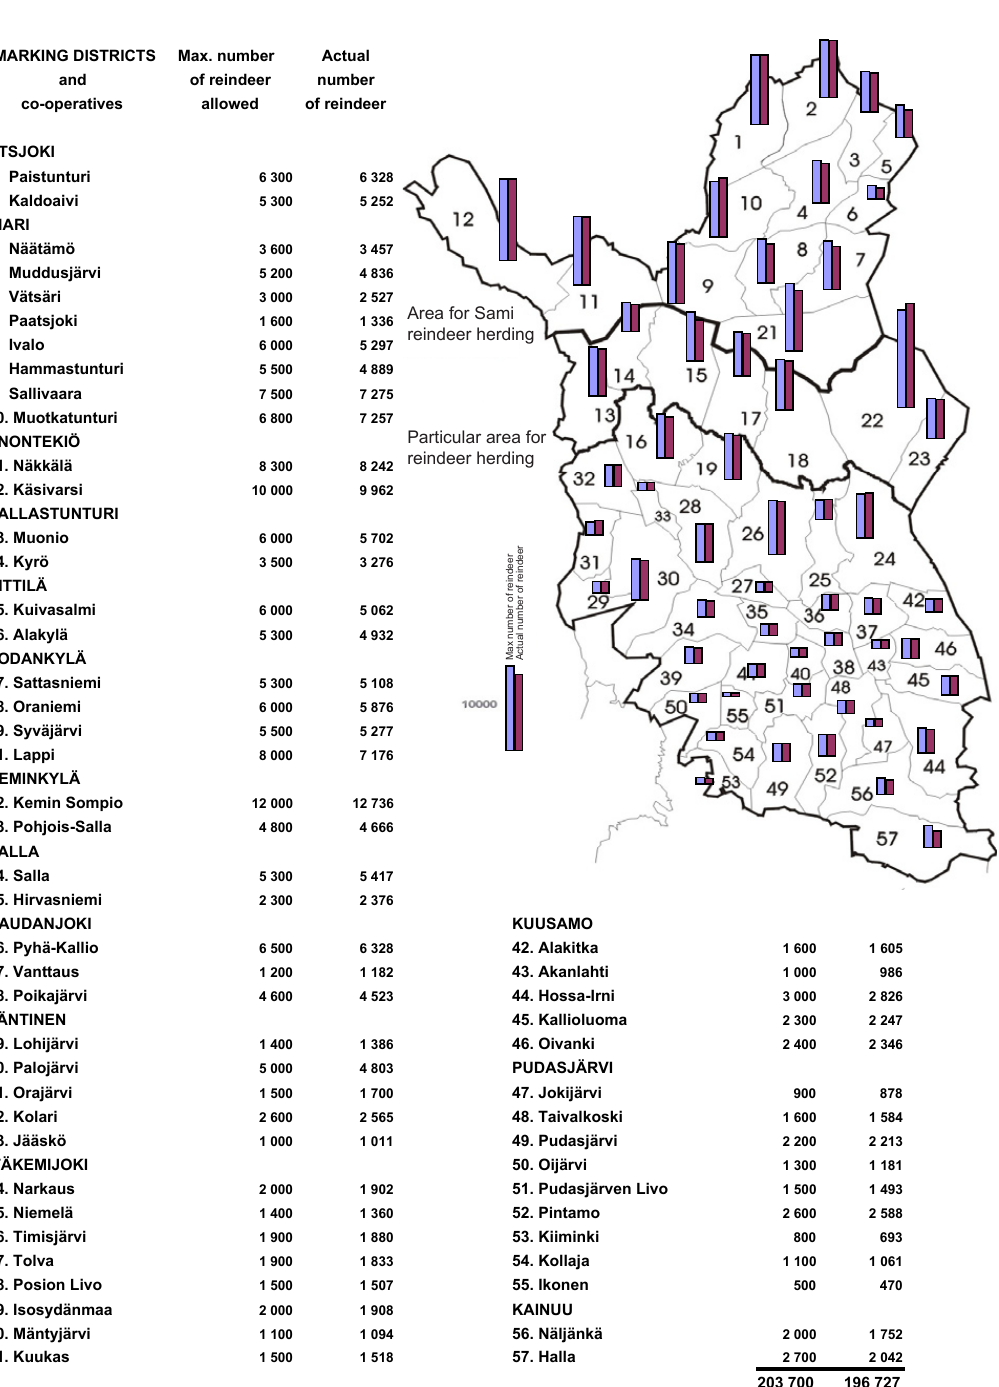
Fig. 1. Areas of reindeer husbandry in Finland